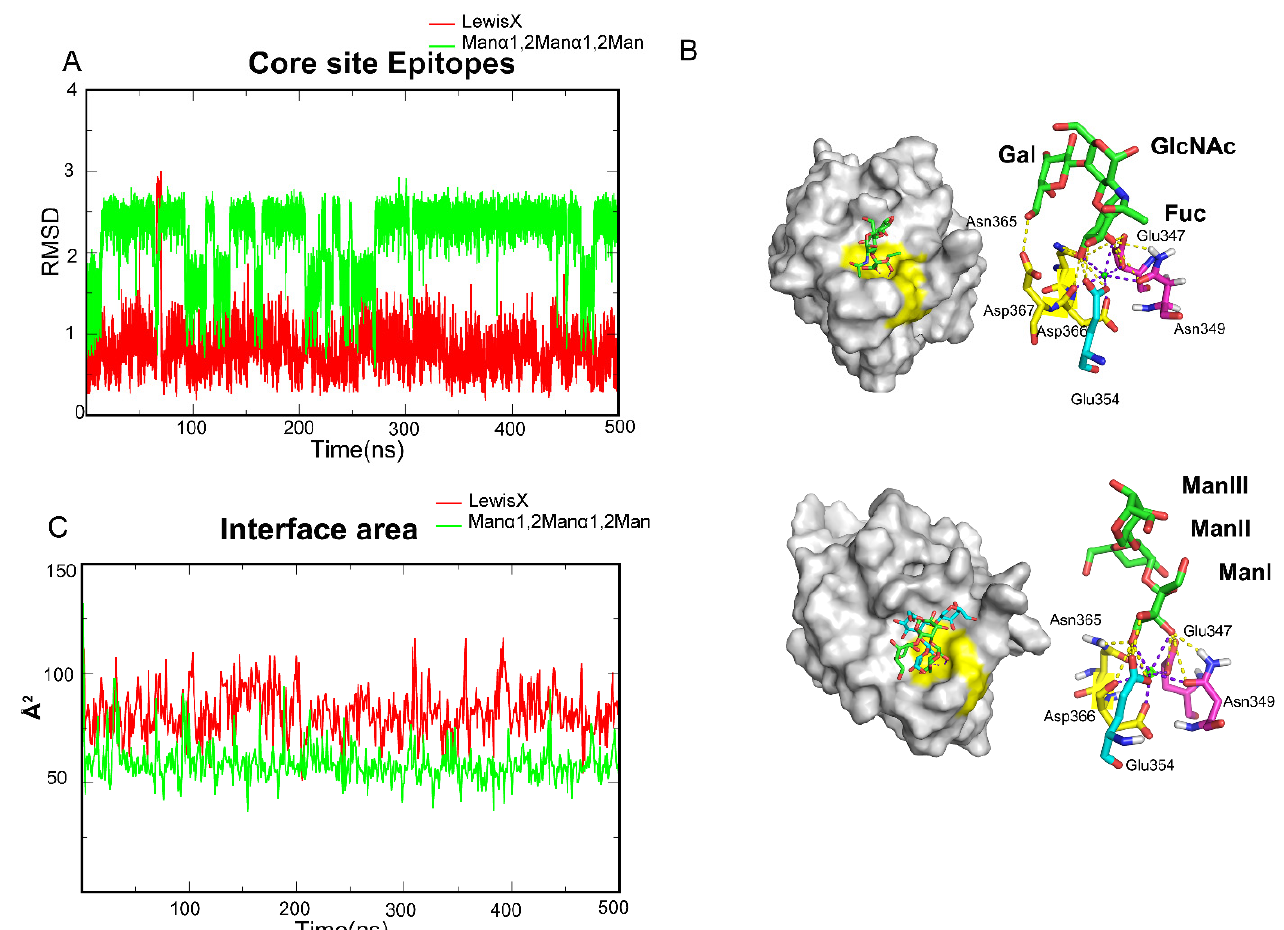
Figure 3. MD simulations showed that DC-SIGN recognizes Lewis X and Man α 1,2Man α 1,2Man only through the Core site. ( A ) RMSD along one of its trajectories about Lewis X and Man α 1,2Man α 1,2Man. LewisX kept a single structure along the trajectory. Man α 1,2Man α 1,2Man showed a conformation change along the trajectory. ( B ) Glu347, Asn349, Glu354, Asn365 and Asp366 fixed the L-Fucose and D-Mannose . Glu347, Asn349, Glu354, Asn365 and Asp366 formed the Core site. Core sites are shown by yellow. ( C ) Interface area between the oligosaccharides and DC-SIGN along the trajectory. Lewis X is more than a monosaccharide and Man α 1,2Man α 1,2Man is about monosaccharides. Lewis X in red, Man α 1,2Man α 1,2Man in light green.